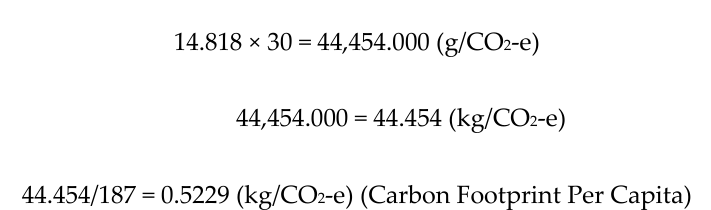
Figure 2. Average per capita carbon footprint for Turkey .